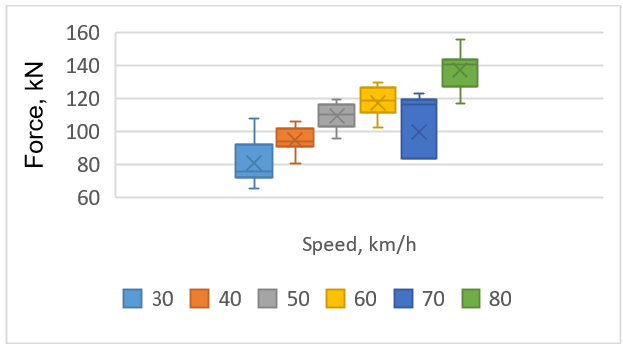
Figure 13. Values of maximal forces of unloaded goods wagon.